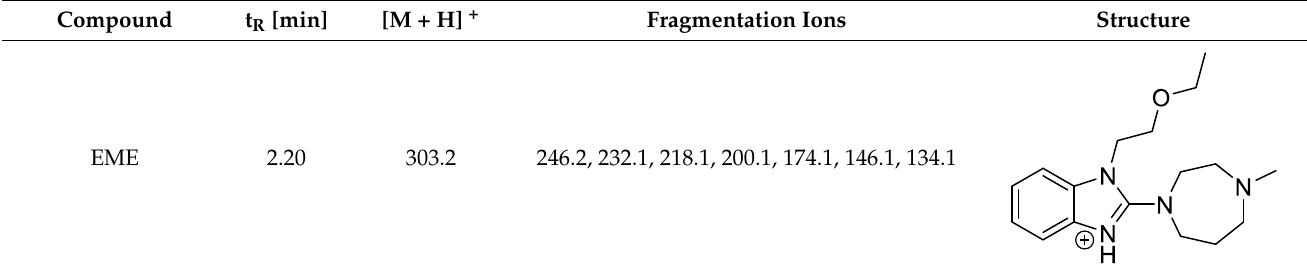
Table 5. MS/MS results for emedastine (EME).